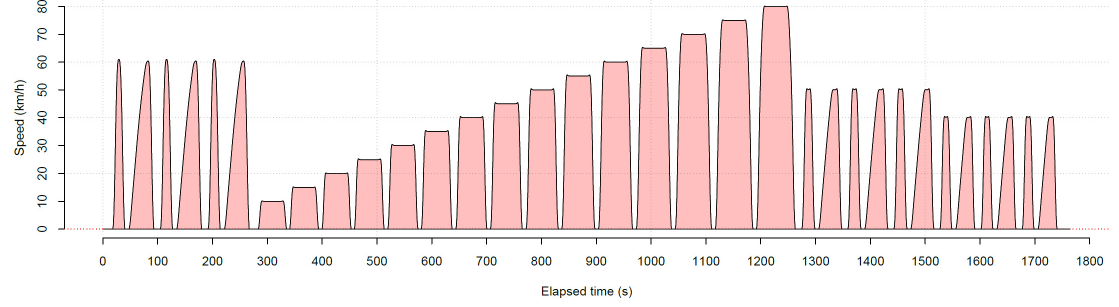
Figure 5. Drive cycle for RSD–dynamometer comparison.